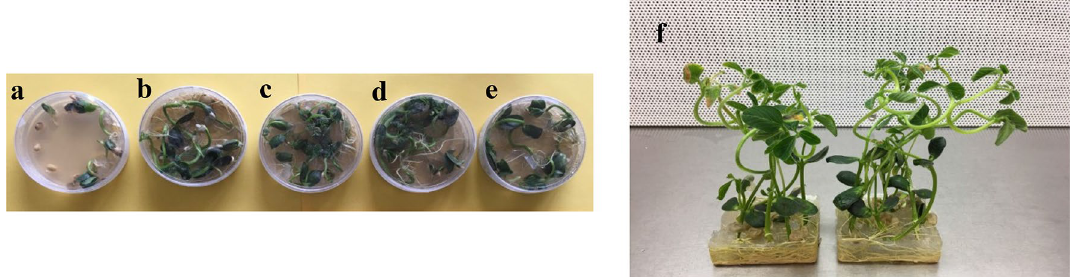
Figure 4. Effect of hygromycin on seed germination on transgenic and wild-type (cv. Jack) soybeans. ( a ) Wild type, in the presence of hygromycin had low germination ratios with inhibited root and shoot growths. ( b – e ) Transgenic soybean lines with high germination ratios and normal root and shoot growth. ( f ) Homozygote transgenic soybean after 3 weeks.